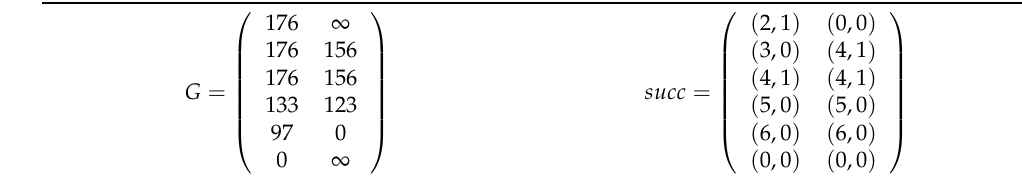
Table 4. Arrays G and succ for the instance in Table